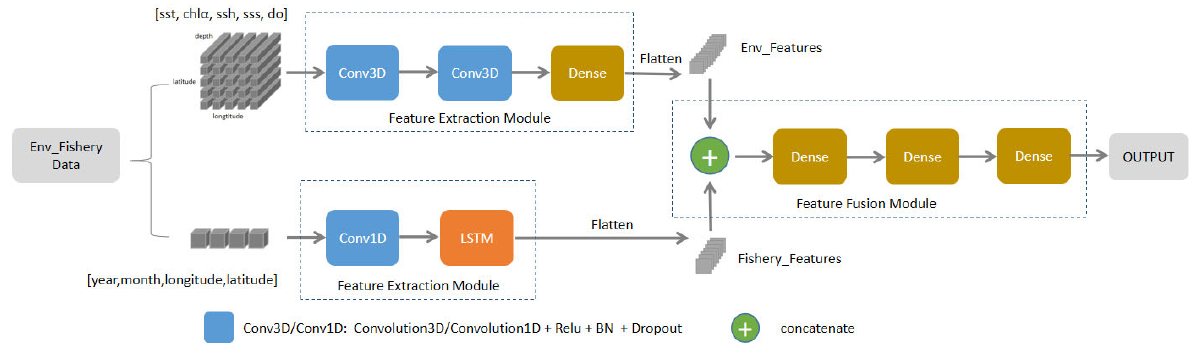
Figure 7. The heterogeneous data feature-extraction model structure with Env_Fishery data as input.